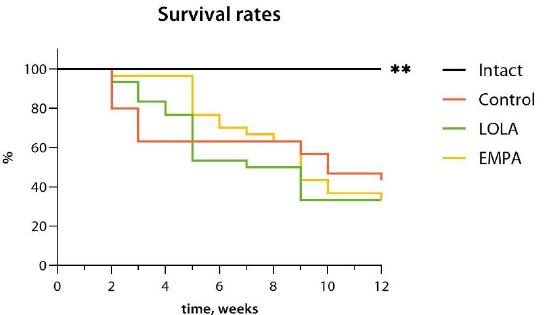
Figure 1. Results of the Kaplan–Meier survival analysis. **, p < 0.01. Schemes follow the same formatting. Gross morphology of representative liver samples from Intact and Control mice is shown in Figure 2. Figure 2. Macroscopic features of experimental liver disease induced in Control mice. ( A ) Intact: normal liver. ( B ) Control: discolored, light tan, stiff liver with a diffuse nodular surface. All Intact samples exhibited portal lymphohistiocytic infiltrate with a granulomatous pattern, indicating the presence of granulomatous hepatitis, which was mild or moderate in the majority (8/10) of the cases. In 1 sample, micro- and macrovesicular steatosis involving less than 1% of the hepatocytes was detected. Mild HCB was found in 3/10 samples, and mild intracellular cholestasis, in 2/10 samples. No signs of necrotic cell death or PPF were detected. All samples were classified as METAVIR F0; however, mild focal CVF was present in 2 of the samples, and another sample showed signs of mild intralobular PSF (Figure 3).